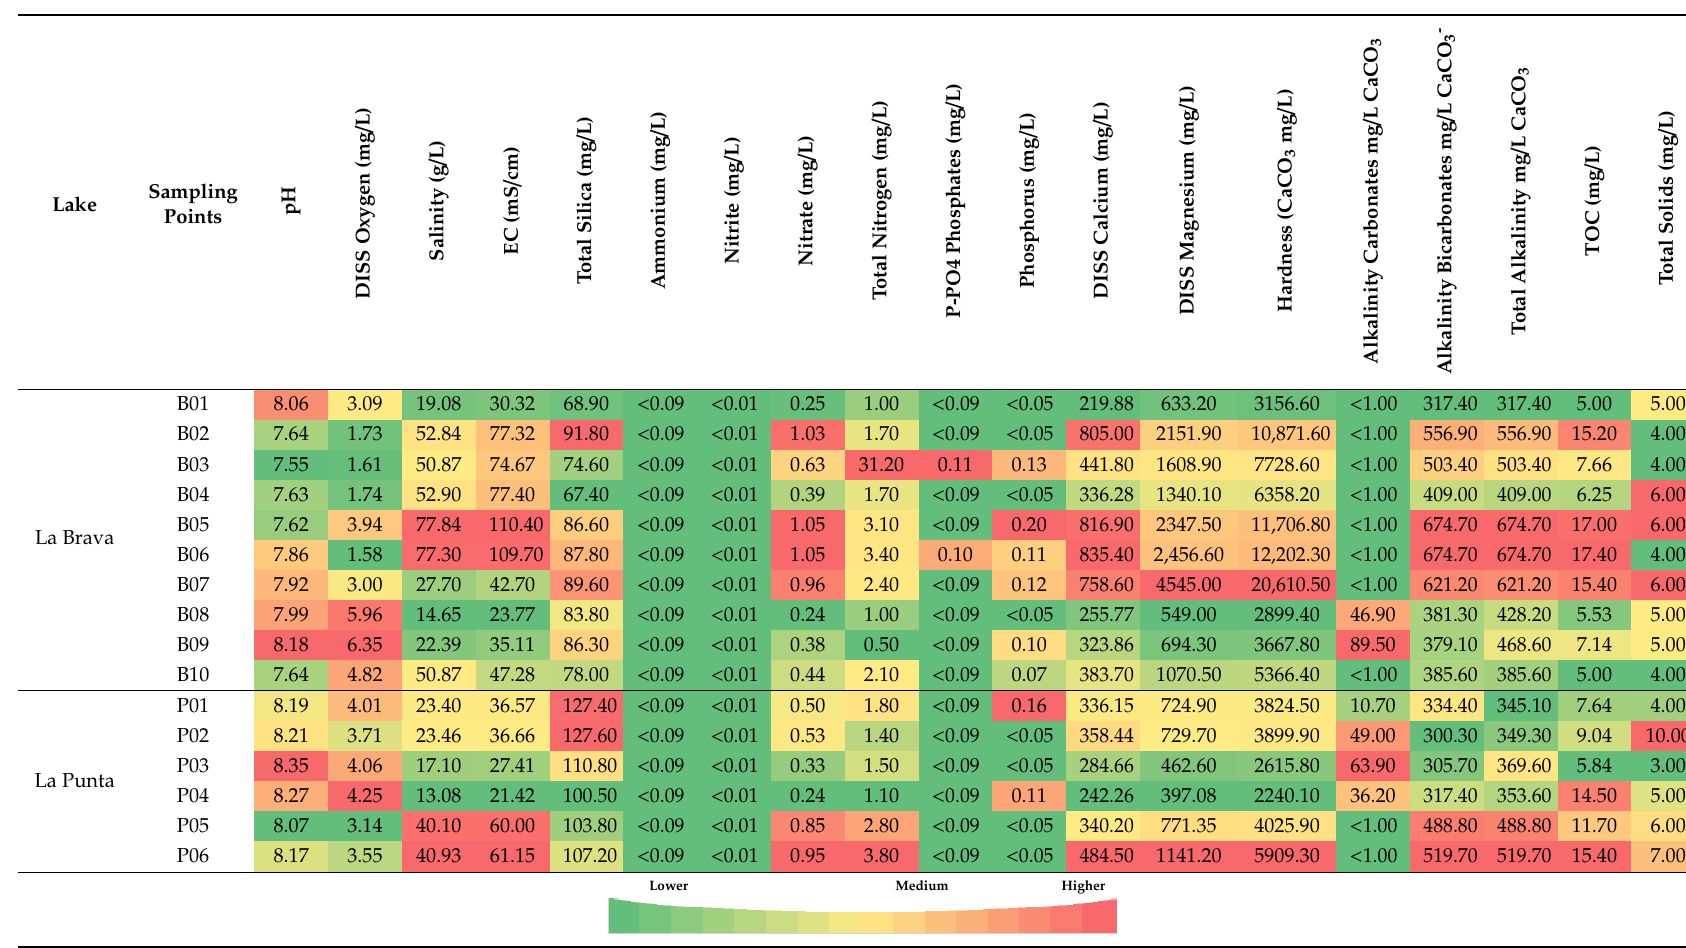
Table 2. Physicochemical parameters of the water columns sampled from the La Brava–La Punta lake system in summer (December 2017).